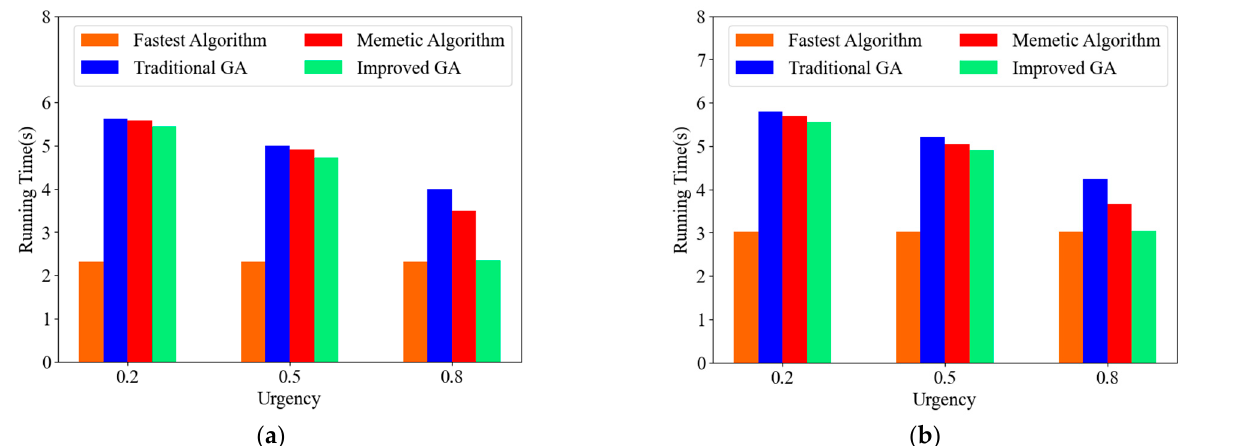
Figure 13. Comparison of algorithm running time under different urgencies. ( a ) Xi’an; ( b ) Wuhan.